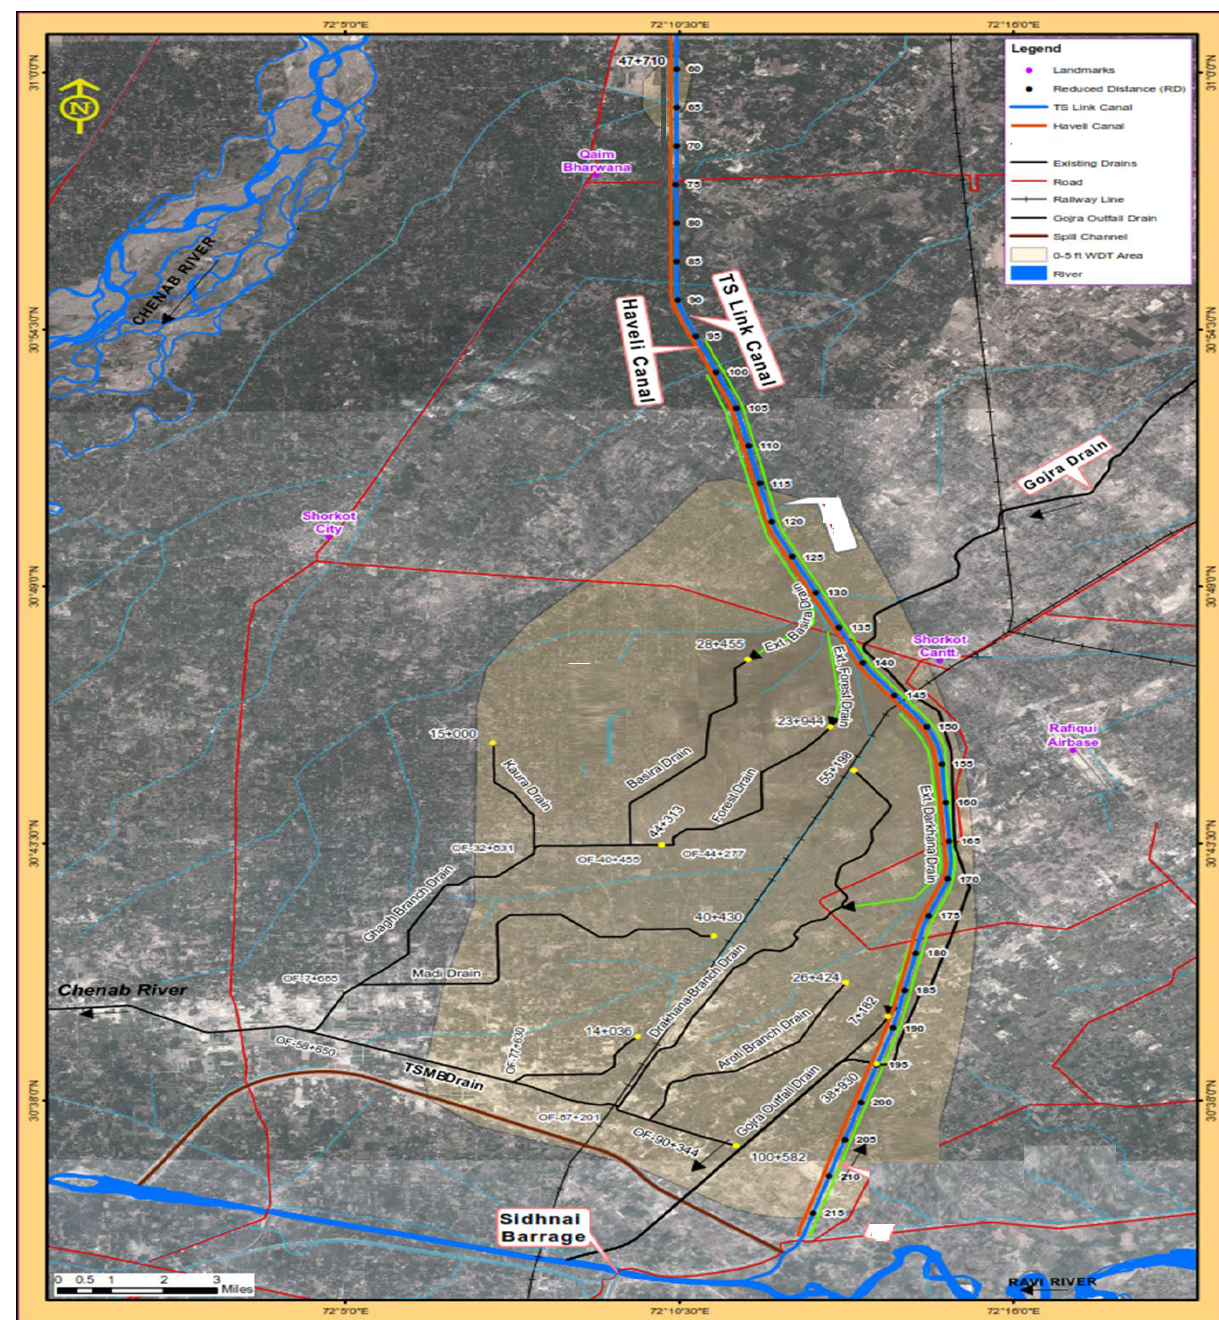
Figure 9. Surface Drainage Network of the Study Area (Source: [30]).